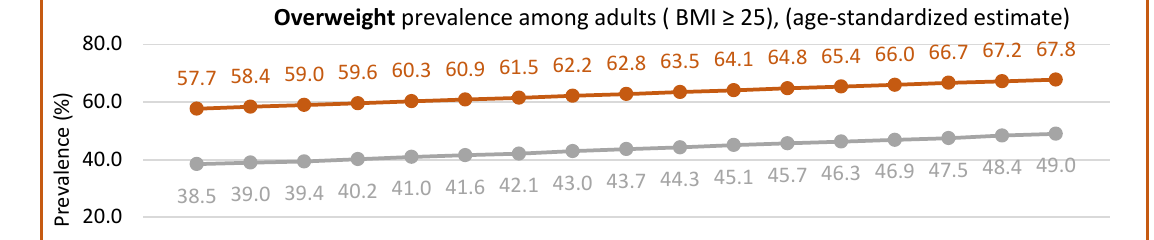
Overweight prevalence among adults ( BMI ≥ 25), (age -standardized estimate)